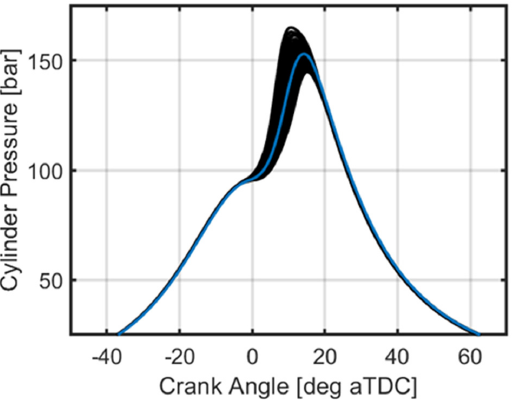
Figure 3. Cylinder pressure vs. crank angle of 300 individual cycles (black) and the average of 300 cycles (blue) for a case where 15% of the fuel is moved from kinetically-controlled injections to a mixing-controlled injection, reducing cyclic variability in the peak pressure. The combustion stabilization imparted by a mixing-controlled injection of fuel is crit- ical to continuing to push the power density of wet ethanol compression ignition.